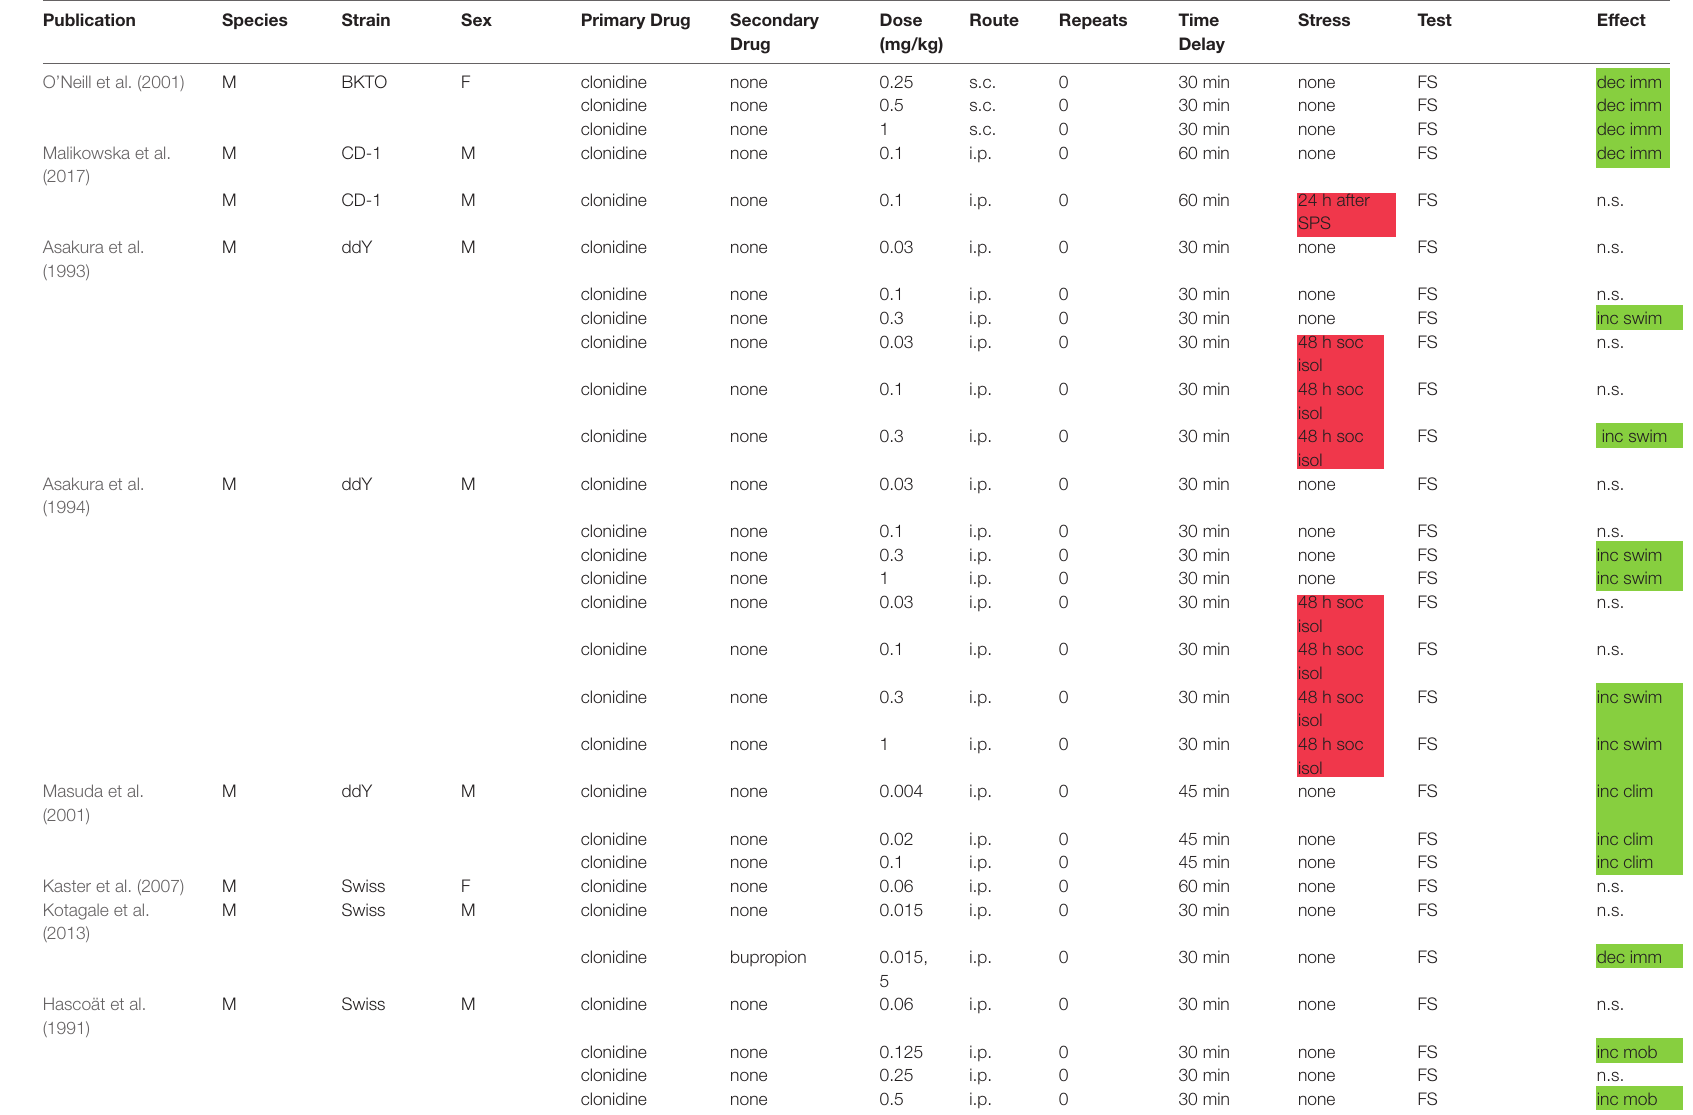
TABLE 1 | Summary of antidepressant-related effects of noradrenergic transmission reducing